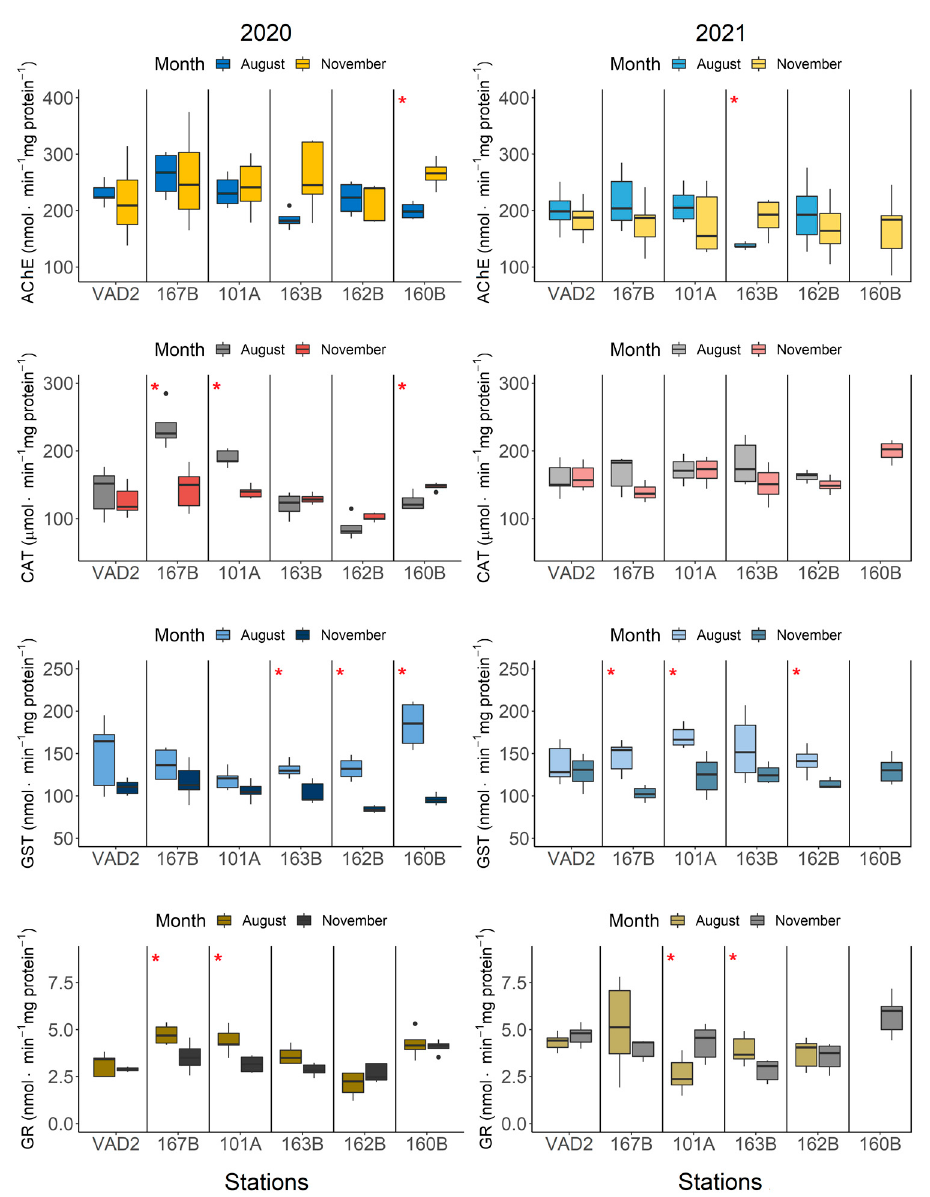
Figure 2. Activity of AChE, CAT, GST, and GR in M. affinis at the coastal stations (20–30 m) in the GoR in August and November 2020 and 2021. The red asterisk indicates statistically significant ( p < 0.05) seasonal differences at the respective stations. Black dots denote outliers calculated according to the Interquartile range (IQR) criterion.